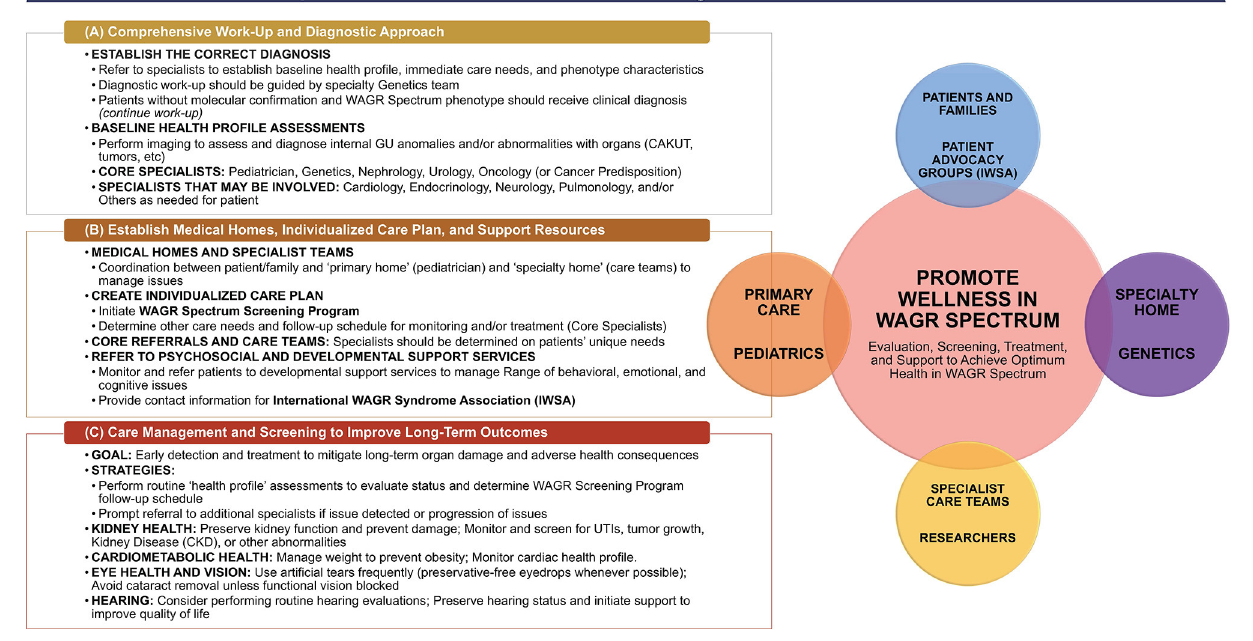
FIGURE 5 | Care management model for WAGR spectrum. Model describes the primary goals, core specialists, and key considerations regarding (A) Initial Work-Up for suspected WAGR Spectrum diagnosis; and (B) Establishment of Care Team and Medical Homes once a diagnosis of WAGR Spectrum is made through molecular and/or clinical evaluation. A multi-disciplinary care management team is needed with additional specialists depending on individual clinical issues with focus on (C) Screening to Improve Long-Term Outcomes for patients with WAGR Spectrum. The goal of this model is to promote wellness within the entire WAGR community, which includes the involvement of care teams, patients, and their families. Psychosocial support should be